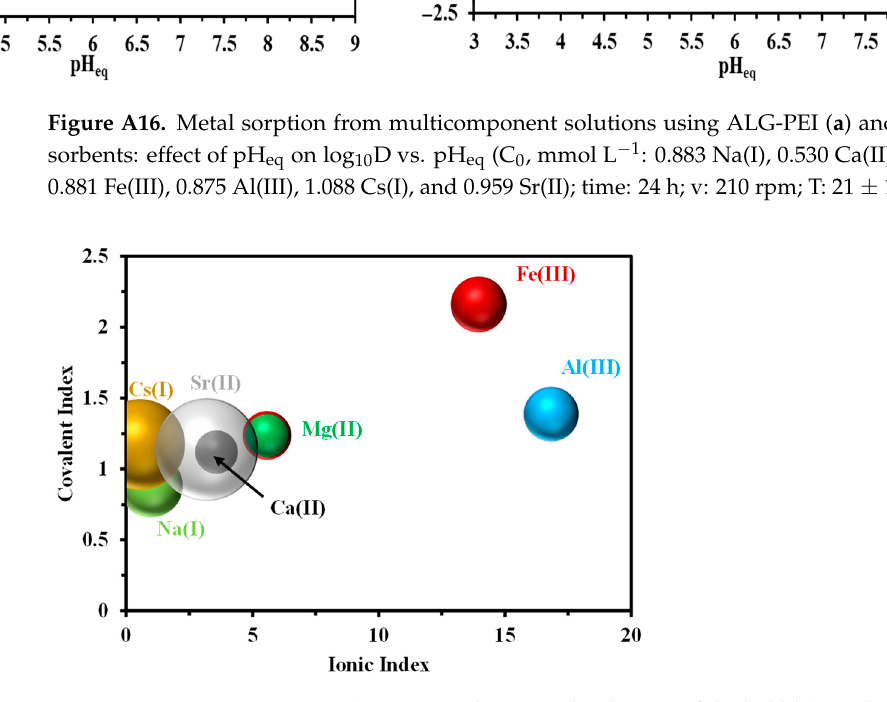
Figure A17. Sorption capacity (proportionality given by the size of the bubble) vs. the positioning of individual metals in the covalent index/ionic index space (data collected from [1,63,100]). Table A7. Summary of main conclusions on selectivity issues.